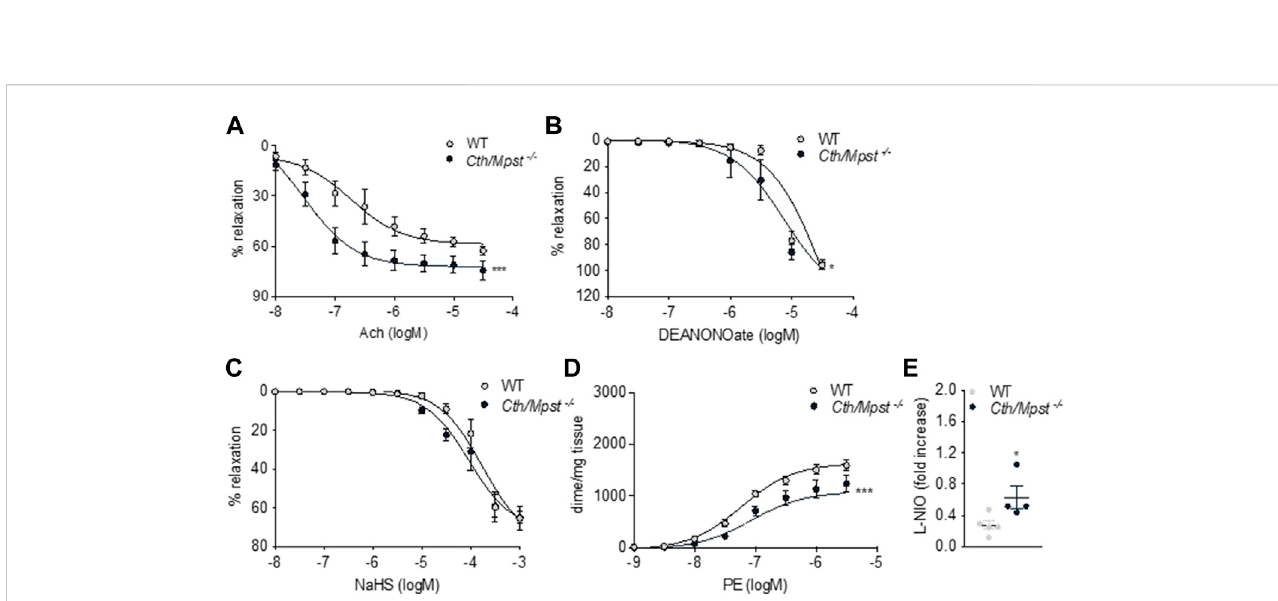
FIGURE 6 Vascular reactivity measurements of aortic rings from WT and Cth/Mpst − / − mice. (A) vasodilatatory response to Ach, (B) vasodilatory responses to (C) the NO donor, DEANONOate and (D) the sul fi de-donor, NaHS, and (D) contractile responses to PE. (E) Increase in tension induced by the exposure of PE-pre- contracted aortic rings (300 nM) to L-NIO (10 µM, 20 min). Data are presented as means ± S.E.M, * p < 0.05 and *** p ≤ 0.001, N = 4-6 mice per